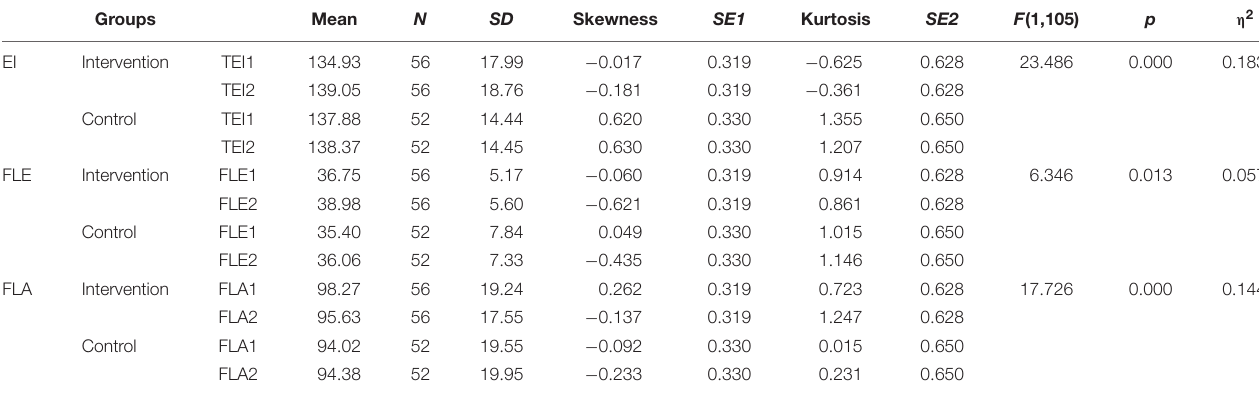
TABLE 6 | Pre- and post-comparison within the intervention and control groups.